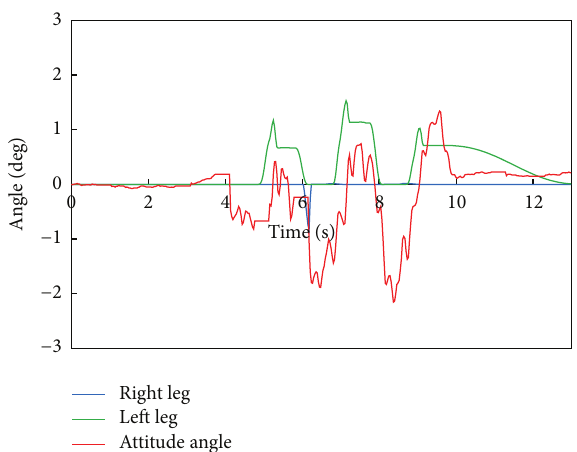
Figure 15: WABIAN-2R’s attitude angle and the modification angle of a swing foot about the roll axis with the human-like foot mechanism.